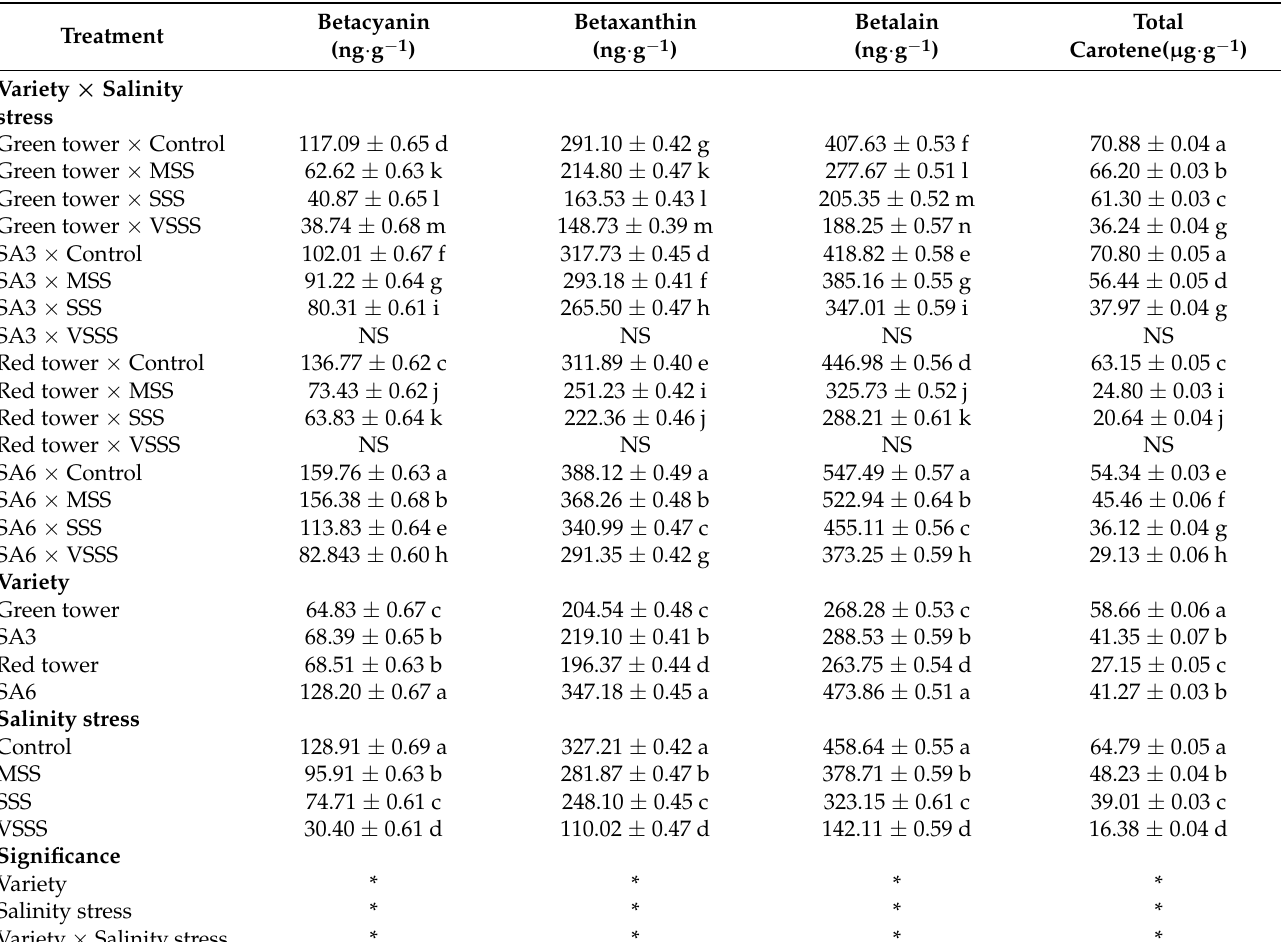
Table 3. Effects of salinity stress on leaf betacyanin, betaxanthin, betalain, and total carotene contents in four selected genotypes of A. lividus leafy